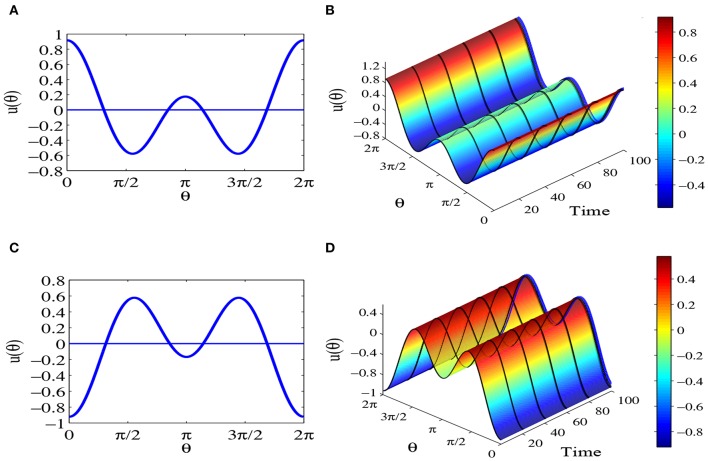
Equilibrium states for parameters a = 0, b = 3 and c = 2, which satisfy 0 < b < 2c and bc≠12. The network contains N = 1000 head-direction cells, τ = 1 and time step Δt = 0.1. (A) The equilibrium solution (55). (B) The time evolution of the equilibrium solution (55), where blue line represents the equilibrium solution (55). (C) The equilibrium solution (57). (D) The time evolution of equilibrium solution (57), where blue line represents the equilibrium solution (57).